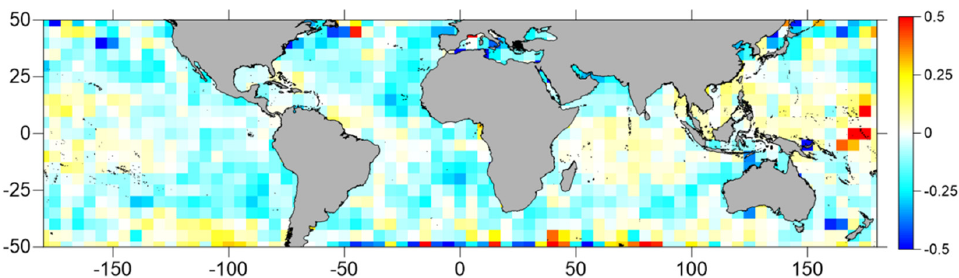
Figure 4. Differences, in cm, between RMS values for Algorithm 1 – Algorithm 2, represented with a 5° by 5° spatial resolution.